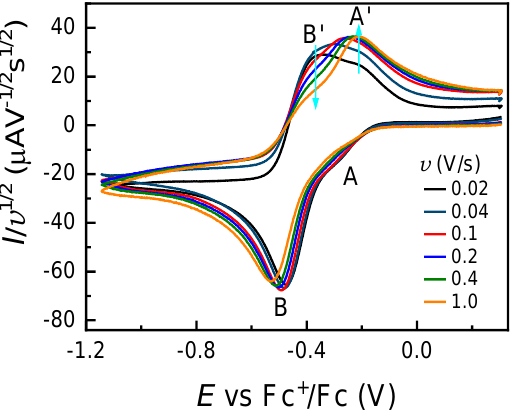
Figure 1. Cyclic voltammetry of 1 mM FeCl 3 in DMF + 0.1 M Et 4 NBF 4 recorded on a GC electrode at different scan rates at T = 25 °C.